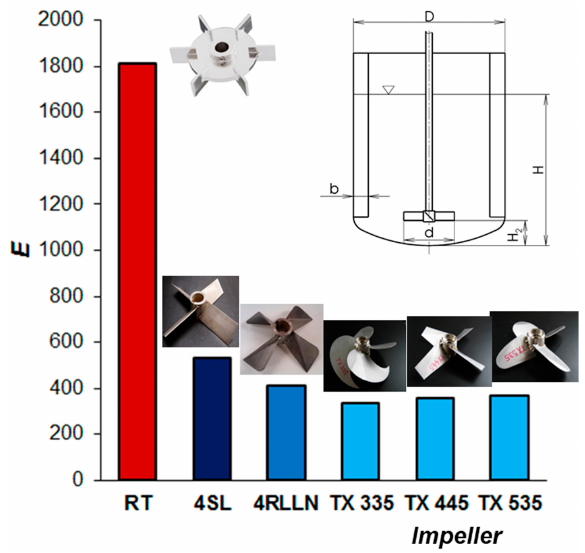
Figure10. Comparisonofdimensionlessenergynecessarytoachievetherequireddegreeofhomogeneity Figure 10. Comparison of dimensionless energy necessary to achieve the required degree of homogeneity of impellers in a cylindrical vessel with radial baffles. of impellers in a cylindrical vessel with radial ba ffl